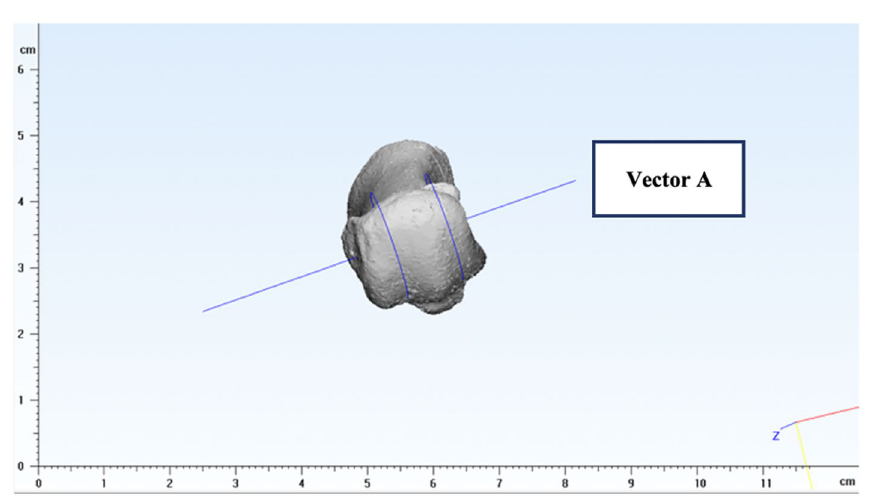
Figure 4. The cylinder was created by the least-square method and the axis of this fitting cylinder represented the position of the distal end of the first